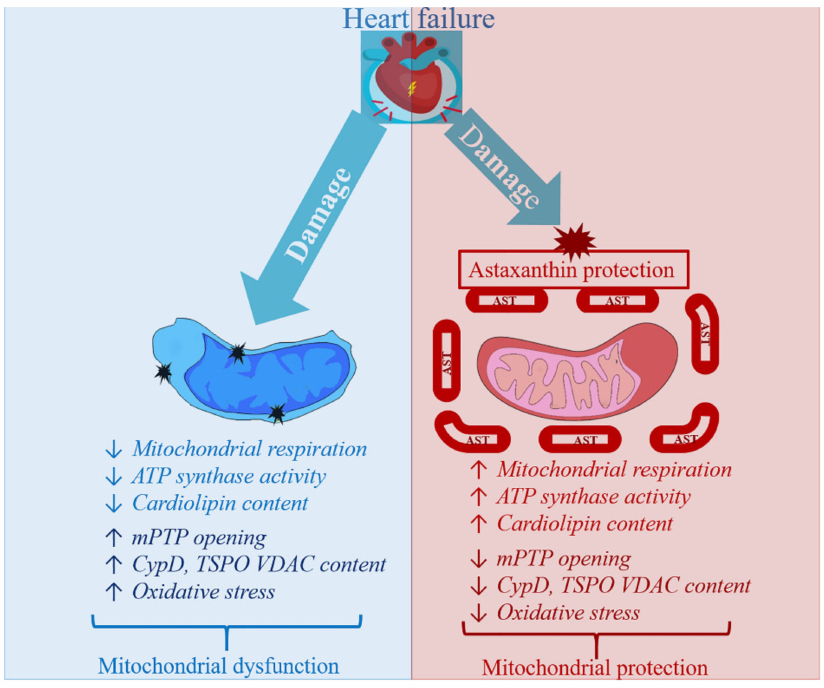
Figure 3. Scheme of the AST effects in Heart failure. Up arrow indicates increase or enhancement, down arrow means decrease or